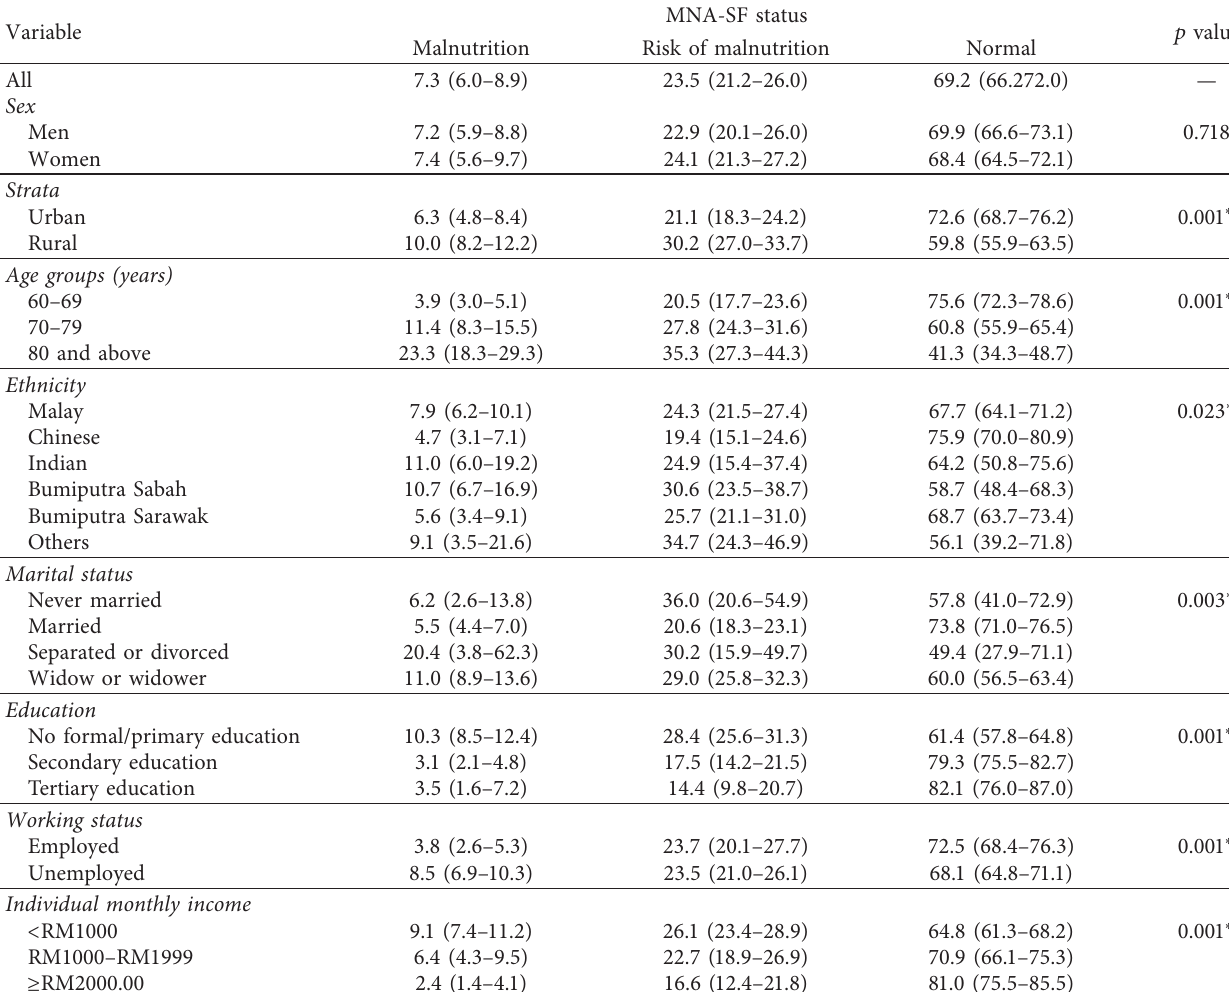
Table 2: Prevalence of malnutrition and risk of malnutrition among the elderly in Malaysia (prevalence (95% CI)).